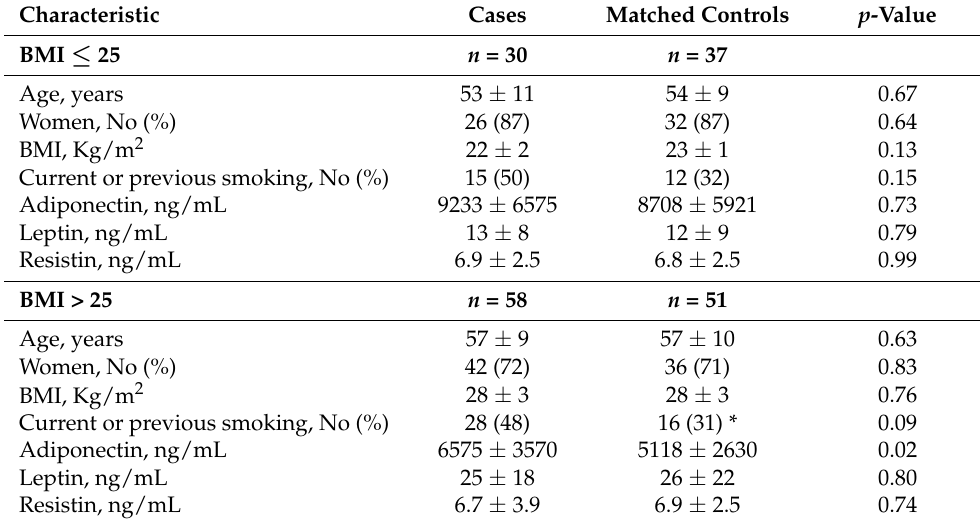
Table 5. Baseline characteristics of the cohort from the Medical Biobank of Northern Sweden stratified by